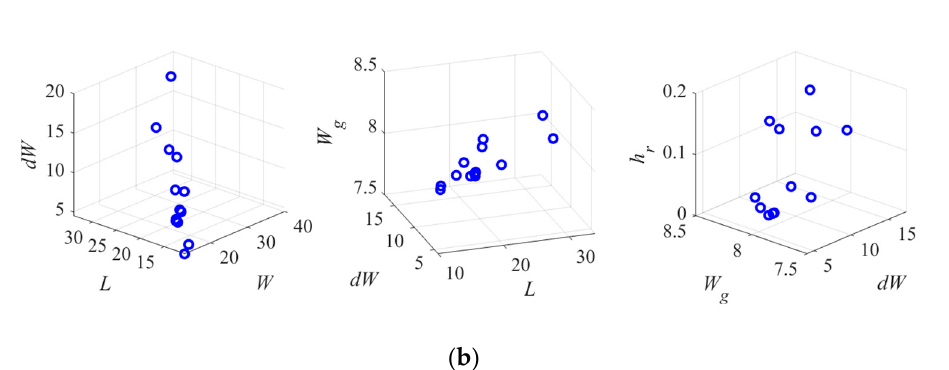
Figure 13. Patch antenna: reflection responses at the selected test designs: EM model (—), nested kriging with variable-thickness domain obtained using 800 training samples and T max = 0.05 (o).